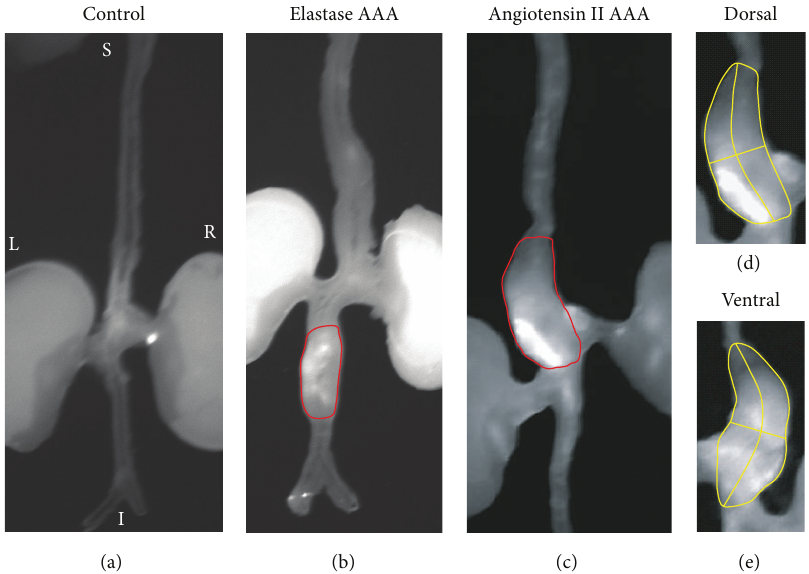
Figure 4: Near-infrared fluorescence (NIRF) image of both angiotensin II-induced and elastase-induced aneurysms. (a) Control apolipoprotein-E deficient mouse aorta after injection of MMPSense 680. (b) Infrarenal aortic aneurysm induced via elastase infusion. (c) Suprarenal aortic aneurysm induced via angiotensin II infusion. (d) Dorsal and (e) ventral NIRF images of angiotensin II-induced abdominal aortic aneurysms showing asymmetric probe accumulation, suggestive of regional differences in protease activation and inflammation. Figure adapted from